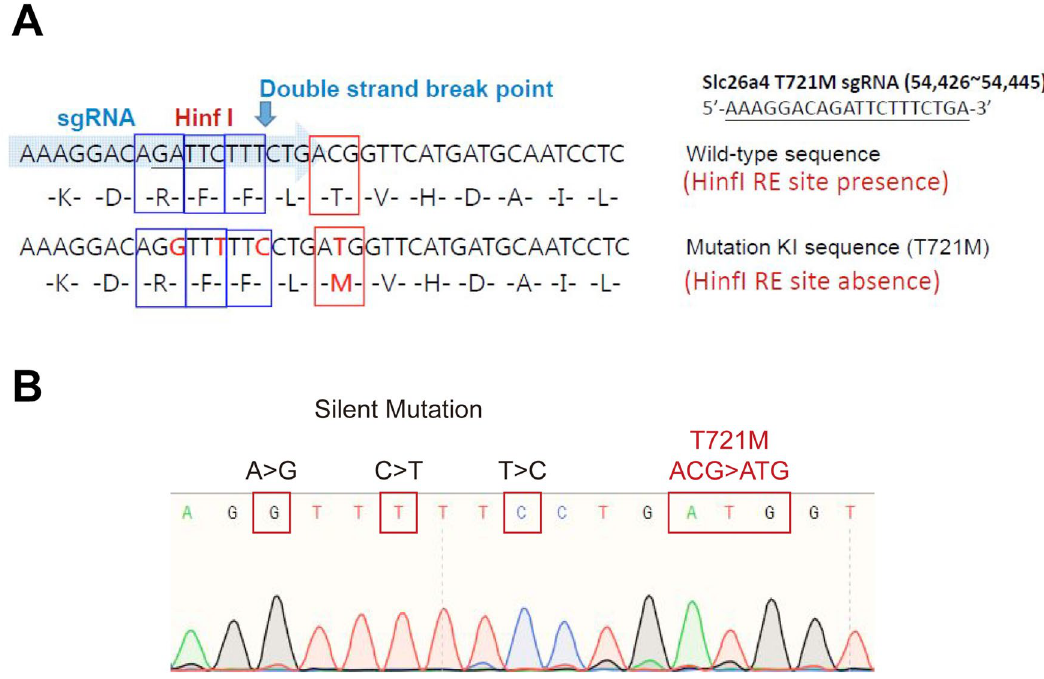
Figure 1. Generation of mice with Slc26a4 p.H721M variant using CRISPR/Cas9. ( A ) Design diagram. SgRNA for CRISPR/Cas9 and silent mutations for enzyme cutting sites as a check were designed to incorporate